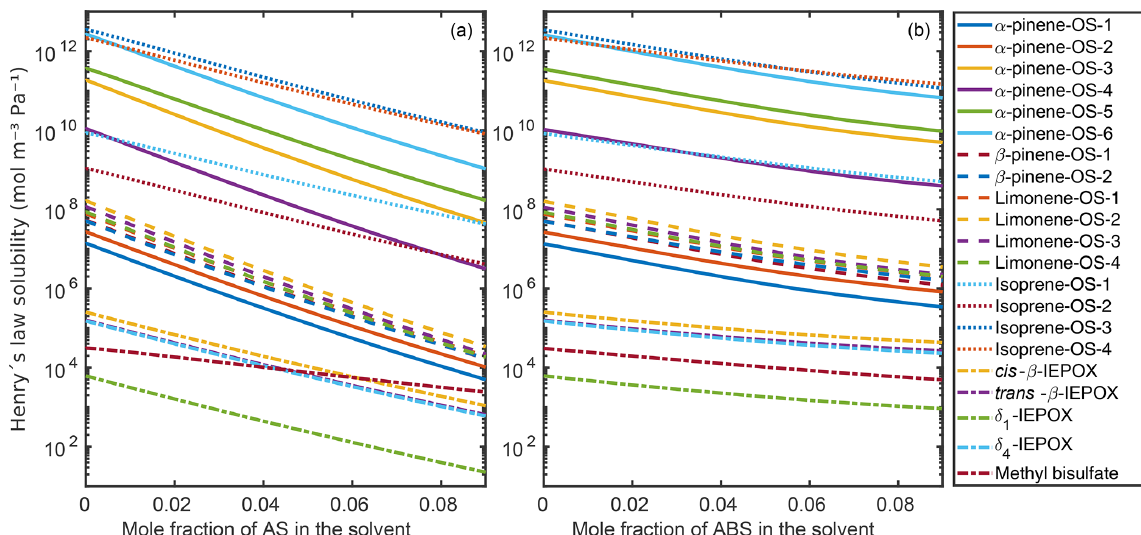
Figure 9. Infinite dilution Henry’s law solubilities in aqueous solutions of (a) ( NH 4 ) 2 SO 4 and (b) NH 4 HSO 4 at